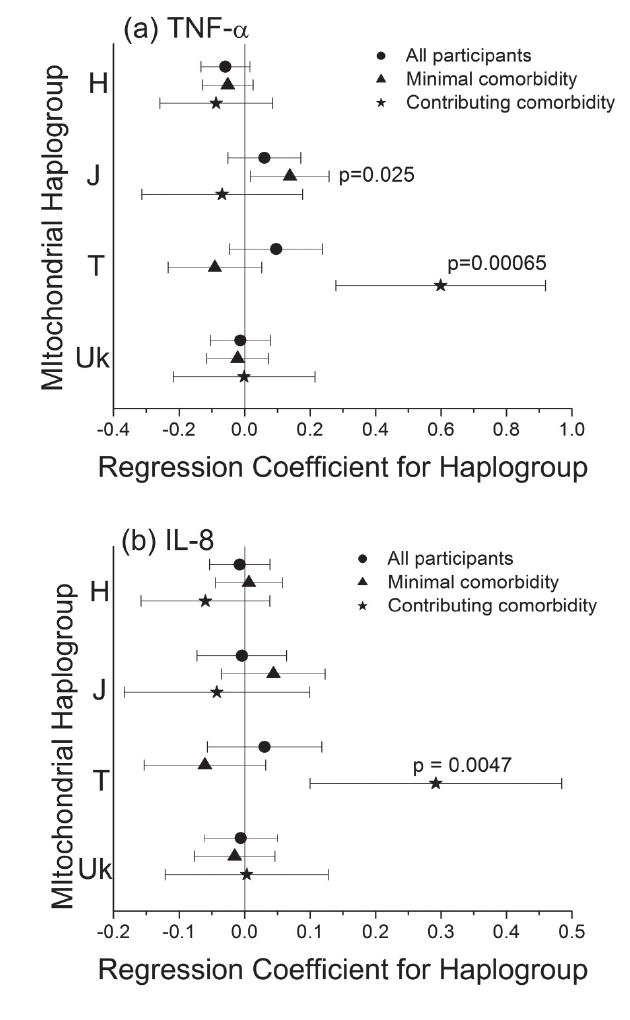
Supplementary Figure 4. Regression coefficients for Log CNS TNF-α (A) and log CNS IL-8 (B). Results are shown for all European ancestry participants (N = 174), and then stratified by comorbidity type (mini- mal [N = 122] or contributing [N = 52]) for neurocognitive